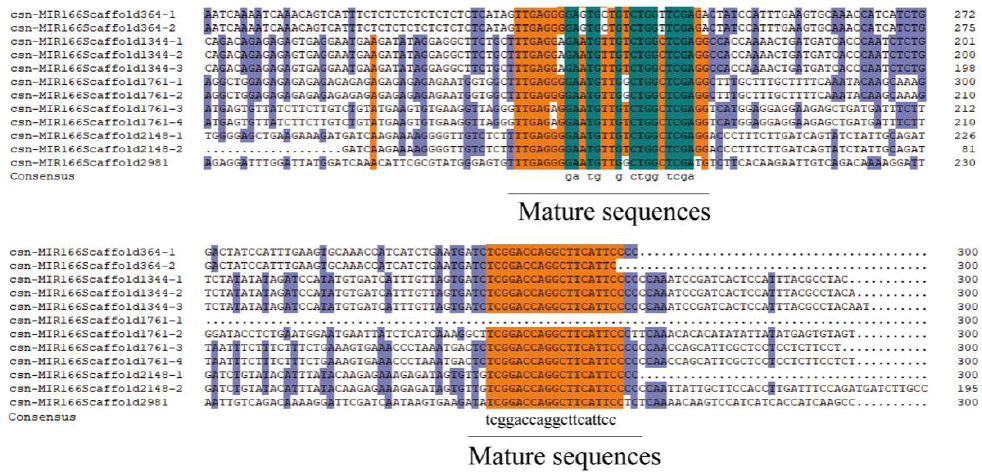
Figure 3. Sequences alignment among C. sinensis pre-miR166. Different highlight colors represent different homology levels of sequence. Green. ≥ 100%; Orange. ≥ 75%; Blue. ≥ 50%.